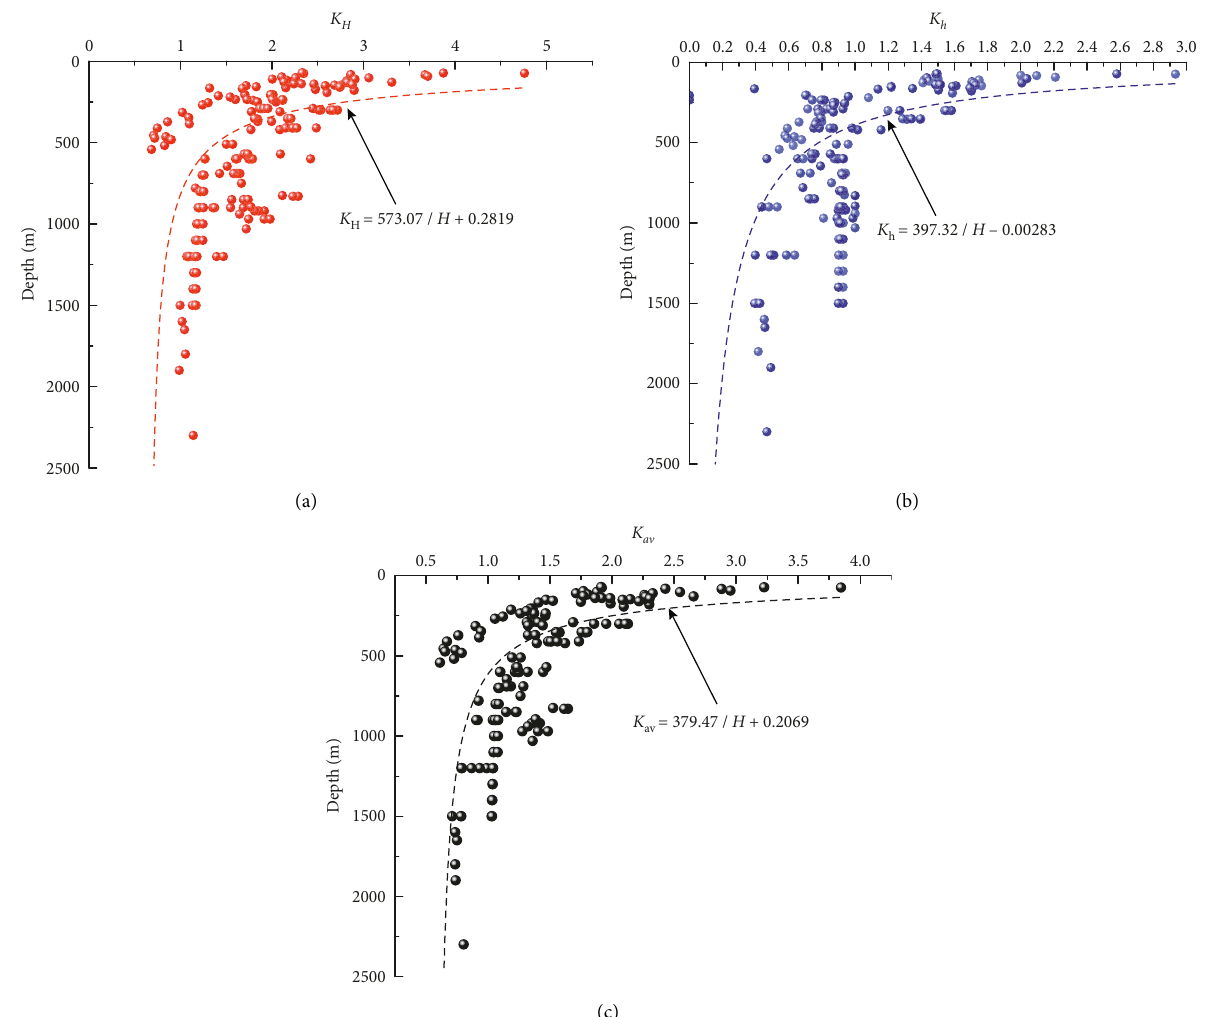
Figure 5: Distribution laws of lateral pressure coefficient with depth and fitting curve. (a–c) Maximum, minimum, and average horizontal lateral pressure coefficients with the depth, respectively.